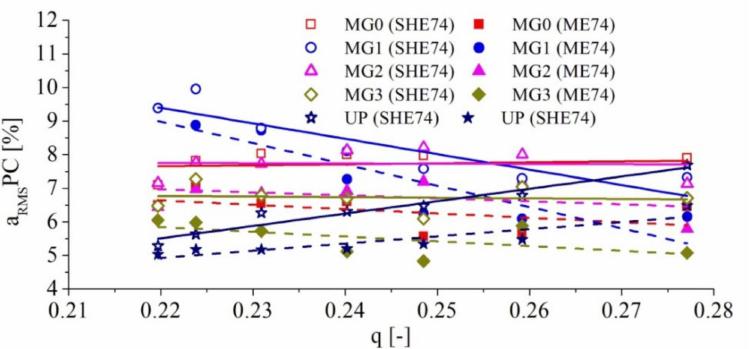
Figure 11. The dimensionless equivalent amplitude of the plunging component (PC) induced by the self-induced flow instabilities on the wall of the test section at all levels (MG0, MG1, MG2, MG3 and UP) for two draft tube configurations (SHE74—solid line, ME74—dashed line) versus the discharge coefficient. Linear fits of the experimental data given by solid and dashed lines highlight the trends. The trends marked with solid lines corresponding to the SHE74 draft tube are on all levels above those associated with the ME74 draft tube with dashed lines. The